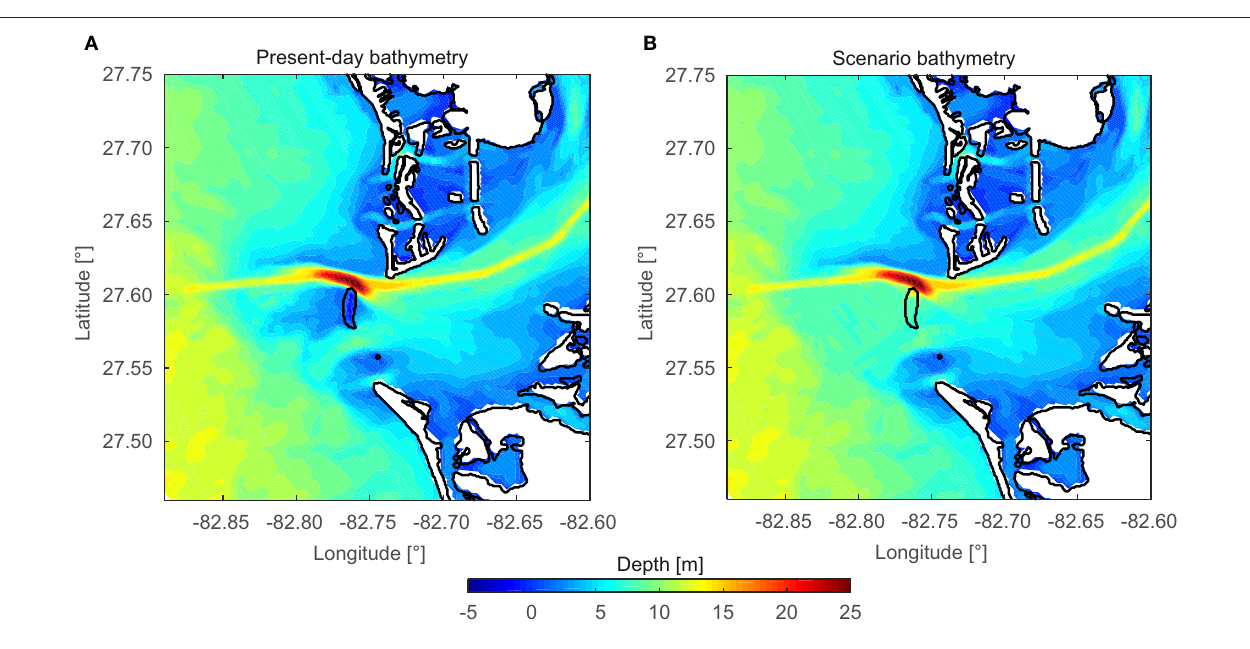
University. The Gulf Model is used to model the transition of the tidal components from the Atlantic into the Gulf of Mexico ocean basin. TPXO 7.2 contains 13 harmonic constituents